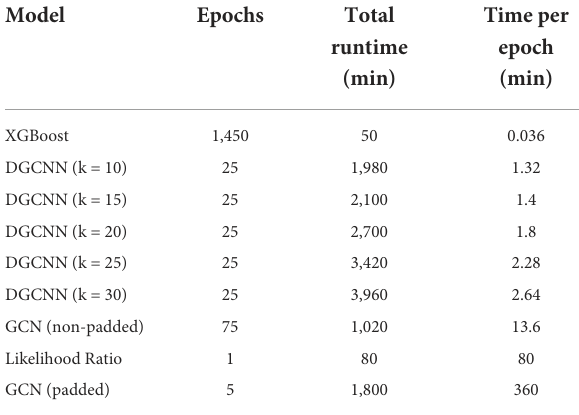
TABLE 3 Comparison of training times for the different models applied in this study, sorted in ascending order by training time per